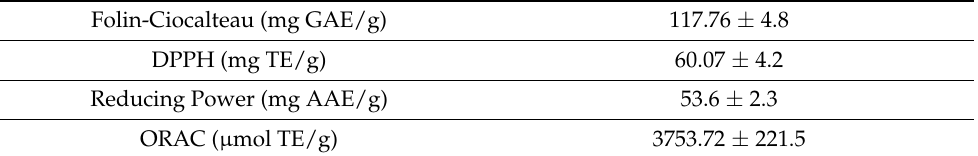
Table 3. Antioxidant activity of MJe evaluated by abiotic assays. Results are reported as mean ± SEM of three experiments performed in triplicate and expressed in standard equivalent/g of dried extract (N = 9).